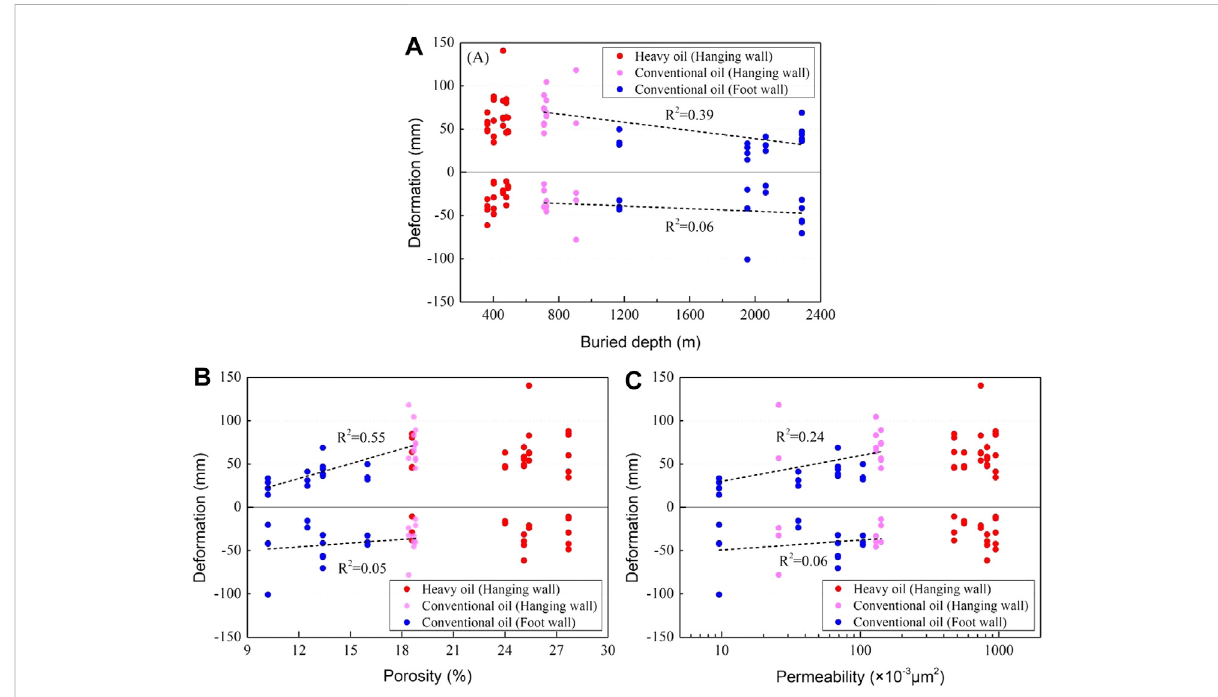
FIGURE 7 Relationship between the buried depth as well as the physical properties of the reservoirs and surface